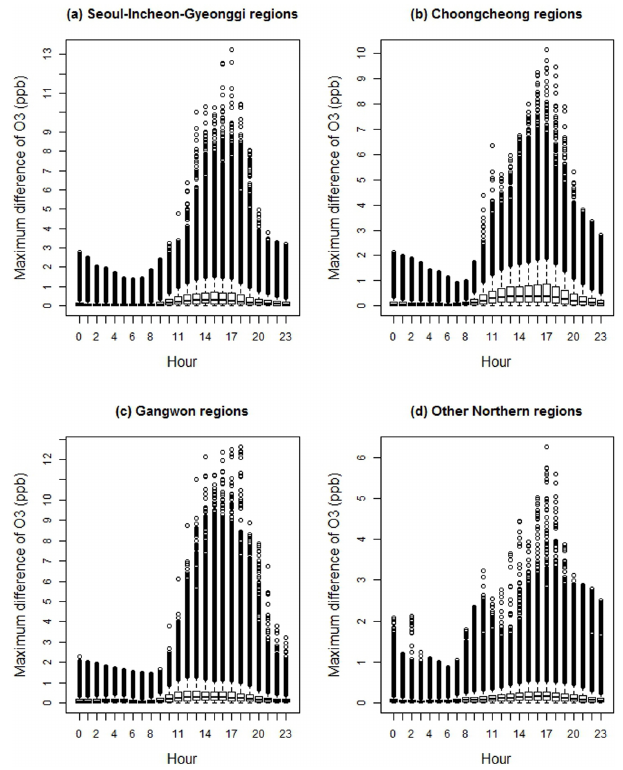
Figure 10. Diurnal distributions of the maximum O 3 differences be- tween different PFT scenarios in subregions derived from CMAQ simulations. The CMAQ simulation was conducted after adjust- ments of anthropogenic isoprene emission input under fixed CMAQ NO x at the level of observed NO x concentrations. Isoprene emis- sion input adjustment was conducted to fix the CMAQ predicted NO x /isoprene ratio at the level of observed the NO x /isoprene ra- tio (see Fig. S4 in the Supplement). For each hour of the day, the boxes represent the range between the 25th and 75th percentile of all maximum difference values for that hour across the simulation period (1–30 June 2008) in the subregions. The line components in boxes indicate the median values. The whiskers indicate the highest (1.5 × IQR (the interquartile range) of the upper quartile) and low- est (1.5 × IQR of the lower quartile) values and connect the extreme points to the